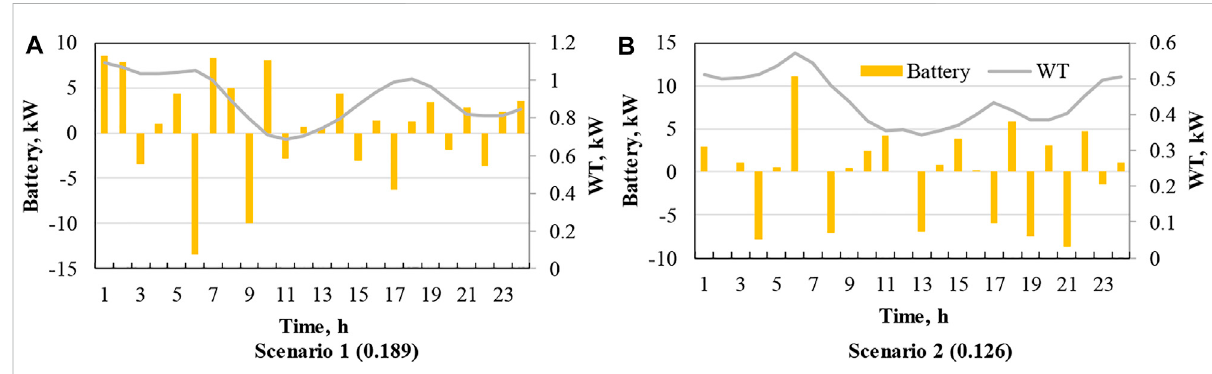
FIGURE 7 Operational strategies of battery and WT under Scenarios 1 (A) and 2 (B) considering CO 2 emission